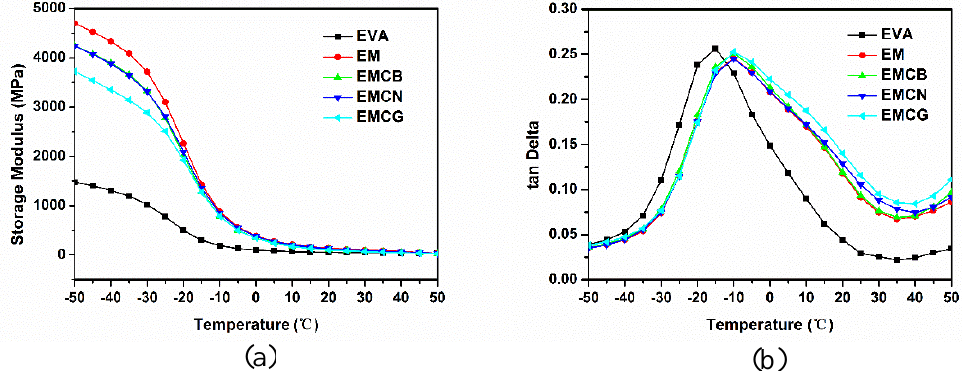
Figure 10. Temperature dependence of ( a ) storage modulus and ( b ) tan δ of pure EVA and its composites.